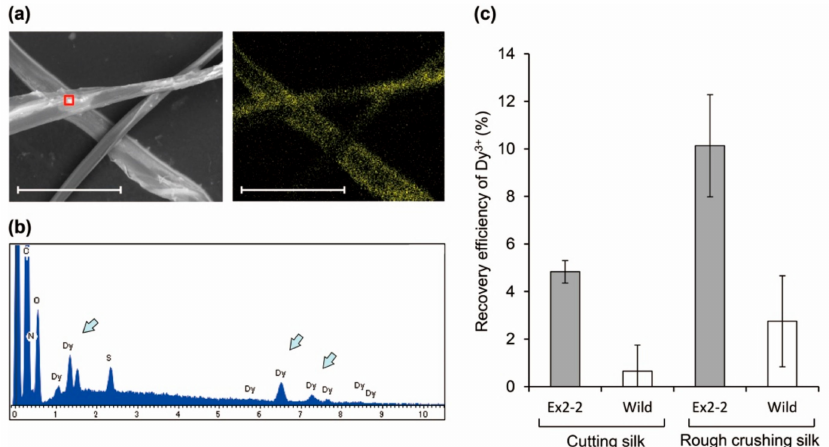
Figure 6. Dy 3 + recognition with silk powder: ( a ) SEM (left) and elemental mapping (right) images of silk powder after Dy 3 + absorption reaction. The yellow signal indicates a Dy. Scale bar, 80 µ m, ( b ) EDX spectrum, each arrow indicates the Dy signal and ( c ) the recovery e ffi ciency of Dy 3 + of silk with harvested silk from Ex2-2. Averages and standard deviations for three independent experiments were represented.